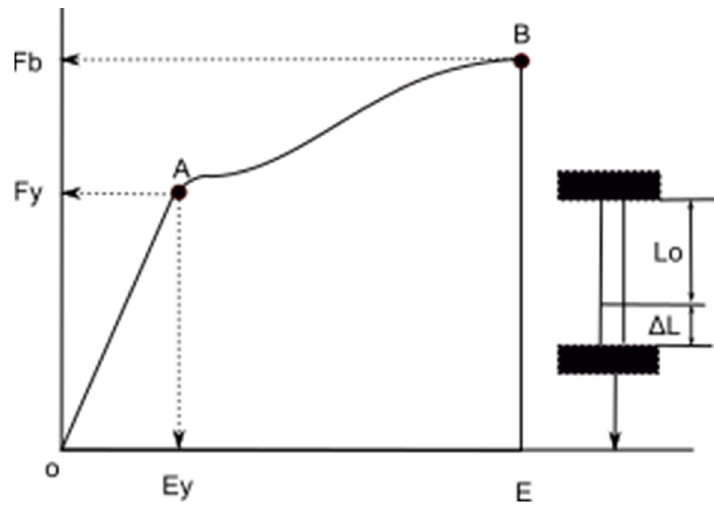
Figure 2. Typical load/elongation